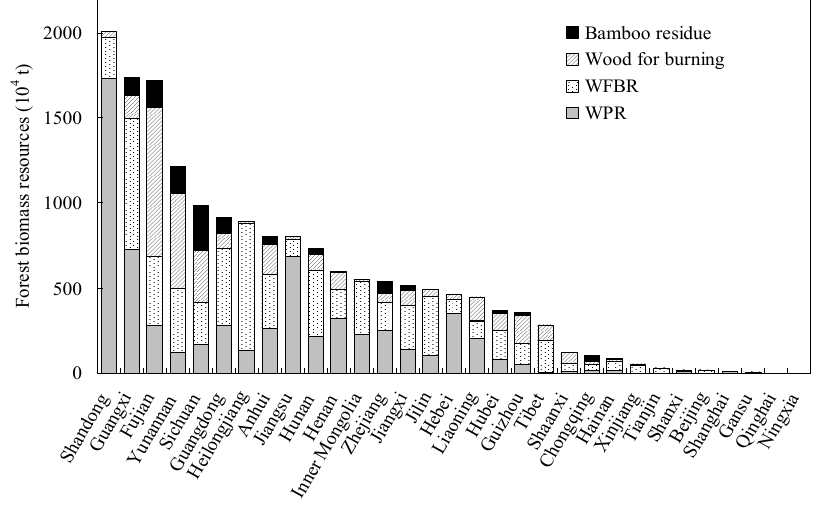
Figure 3. Comparison of different forestry bioenergy resources at a provincial scale in China.